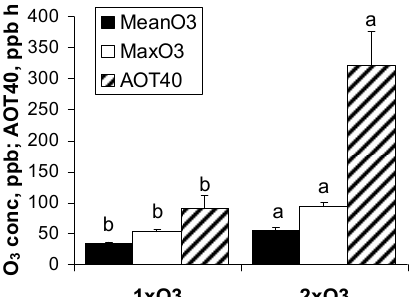
Figure 1. Descriptors of ozone exposure at ambient (1xO 3 ) and twice-ambient ozone (2xO 3 ). Data are daily means of hourly concentrations and accumulated hourly values above 40 ppb ( + SE) in July 2007. Different letters show significant differences between the ozone regimes ( t -test or Mann–Whitney U test, p < 0.001, n = 31 days).